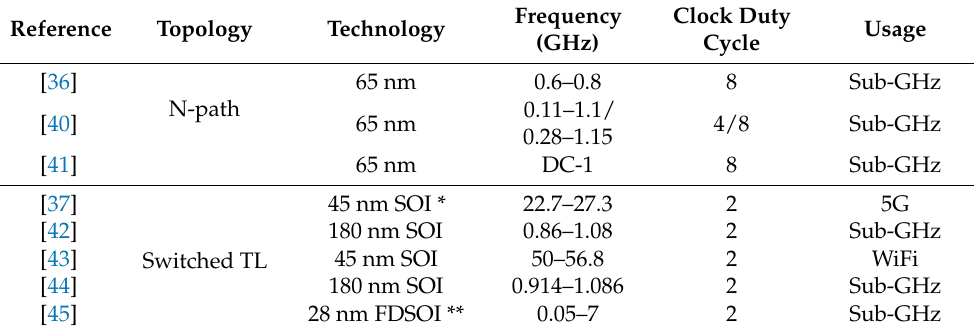
Table 1. Summary of prior literature and proposed